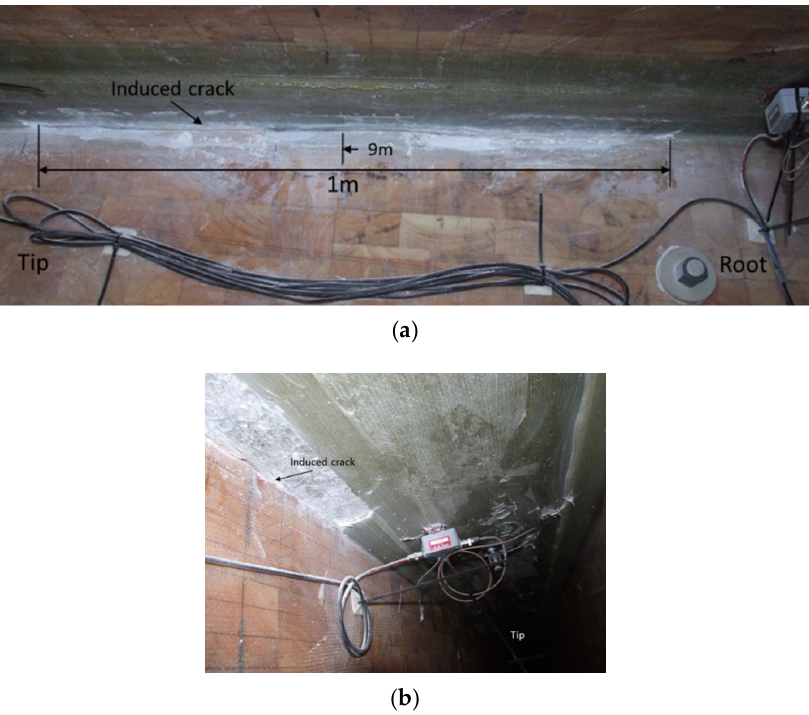
Figure 7. Extension of the crack to 1000 mm at 9 m from the blade root. View from ( a ) outside of the shear web box; ( b ) from inside of the shear web box.